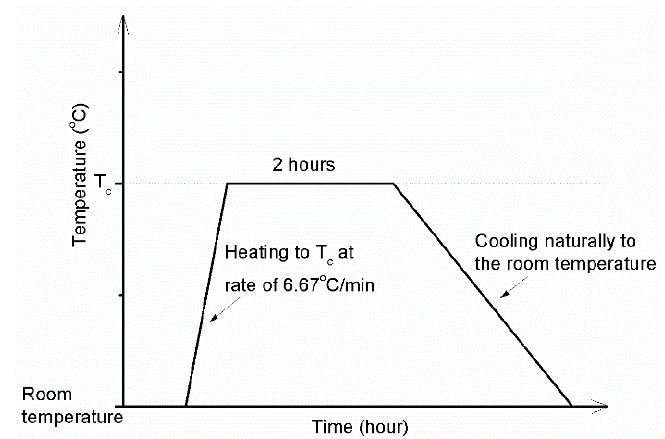
Figure 2. Temperature profile curve of furnace.